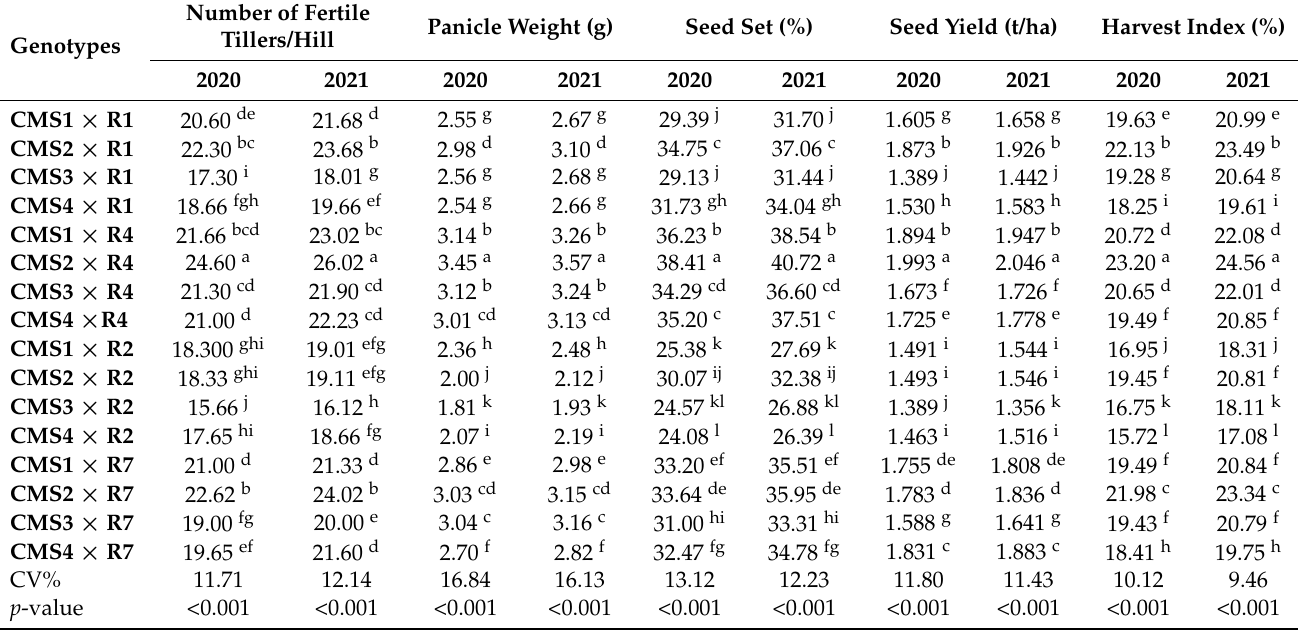
Table 4. Hybrid seed production of four diverse CMS lines crossed with promising restorer lines and their parental cultivars during the 2020 and 2021 rice-growing